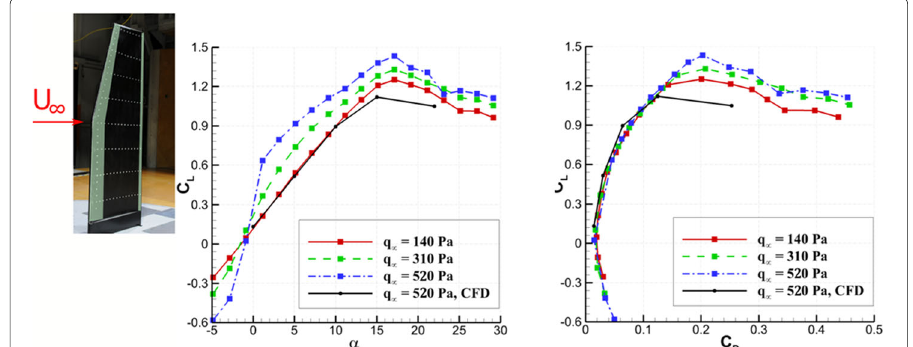
Fig. 6 Evolution of C L - α and C L - C D obtained with the experiments at three q ∞ and with CFD computations at q ∞ = 520